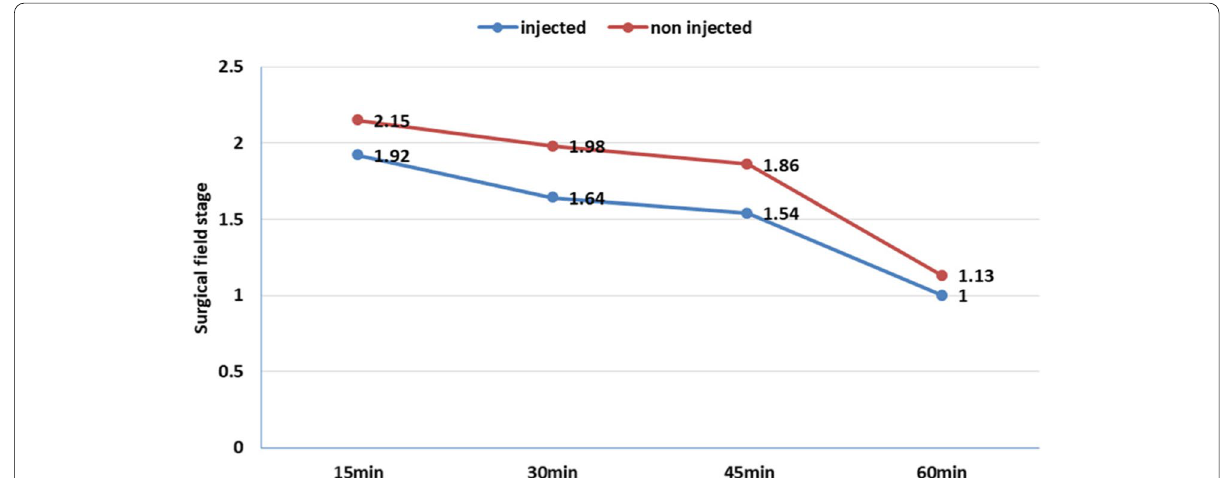
Fig. 7 Comparison between injected and non‑injected side as regards surgical field stage of bleeding according to Boezaart at different time